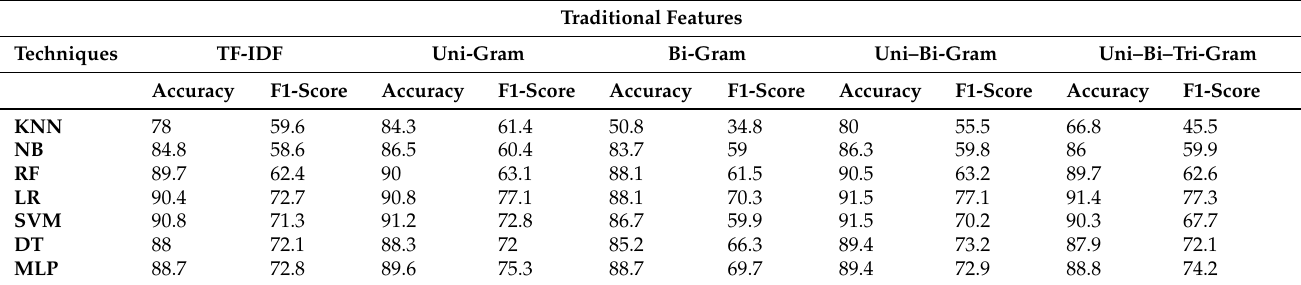
Table 10. Machine learning classifiers applied on ternary labeled